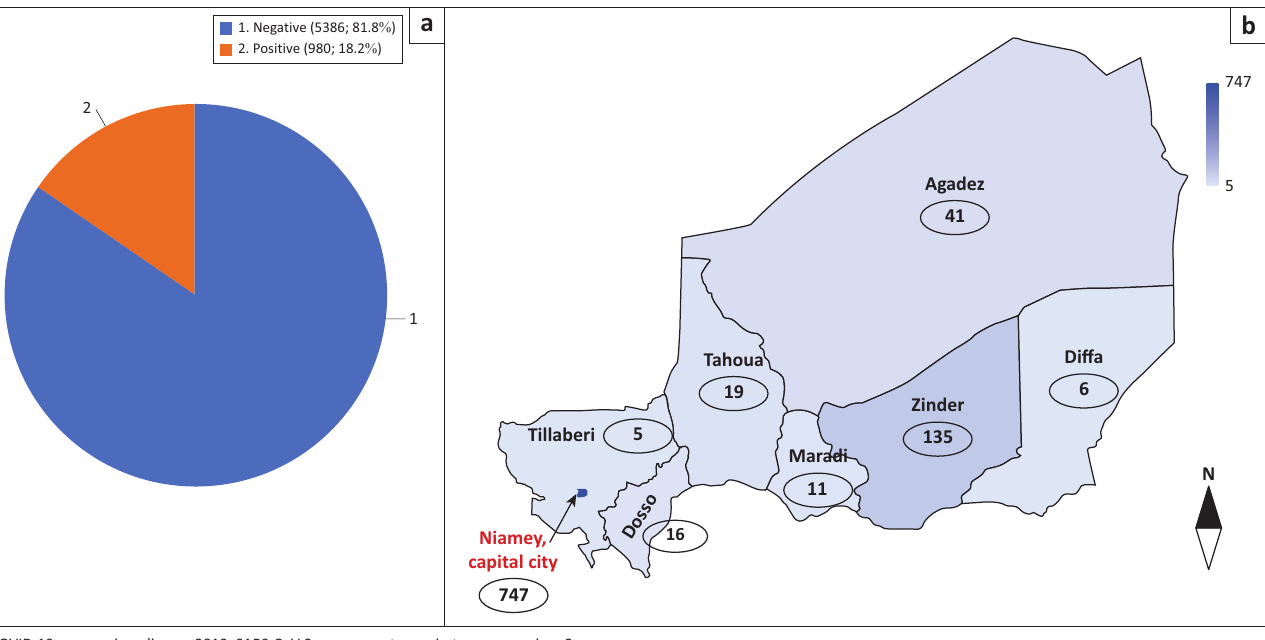
FIGURE 2: COVID-19 situation in Niger as of 15 June 2020. (a) Numbers of SARS-CoV-2 RNA-positive patients. (b) Map of Niger showing the distribution of SARS-CoV-2- positive patients according to region.